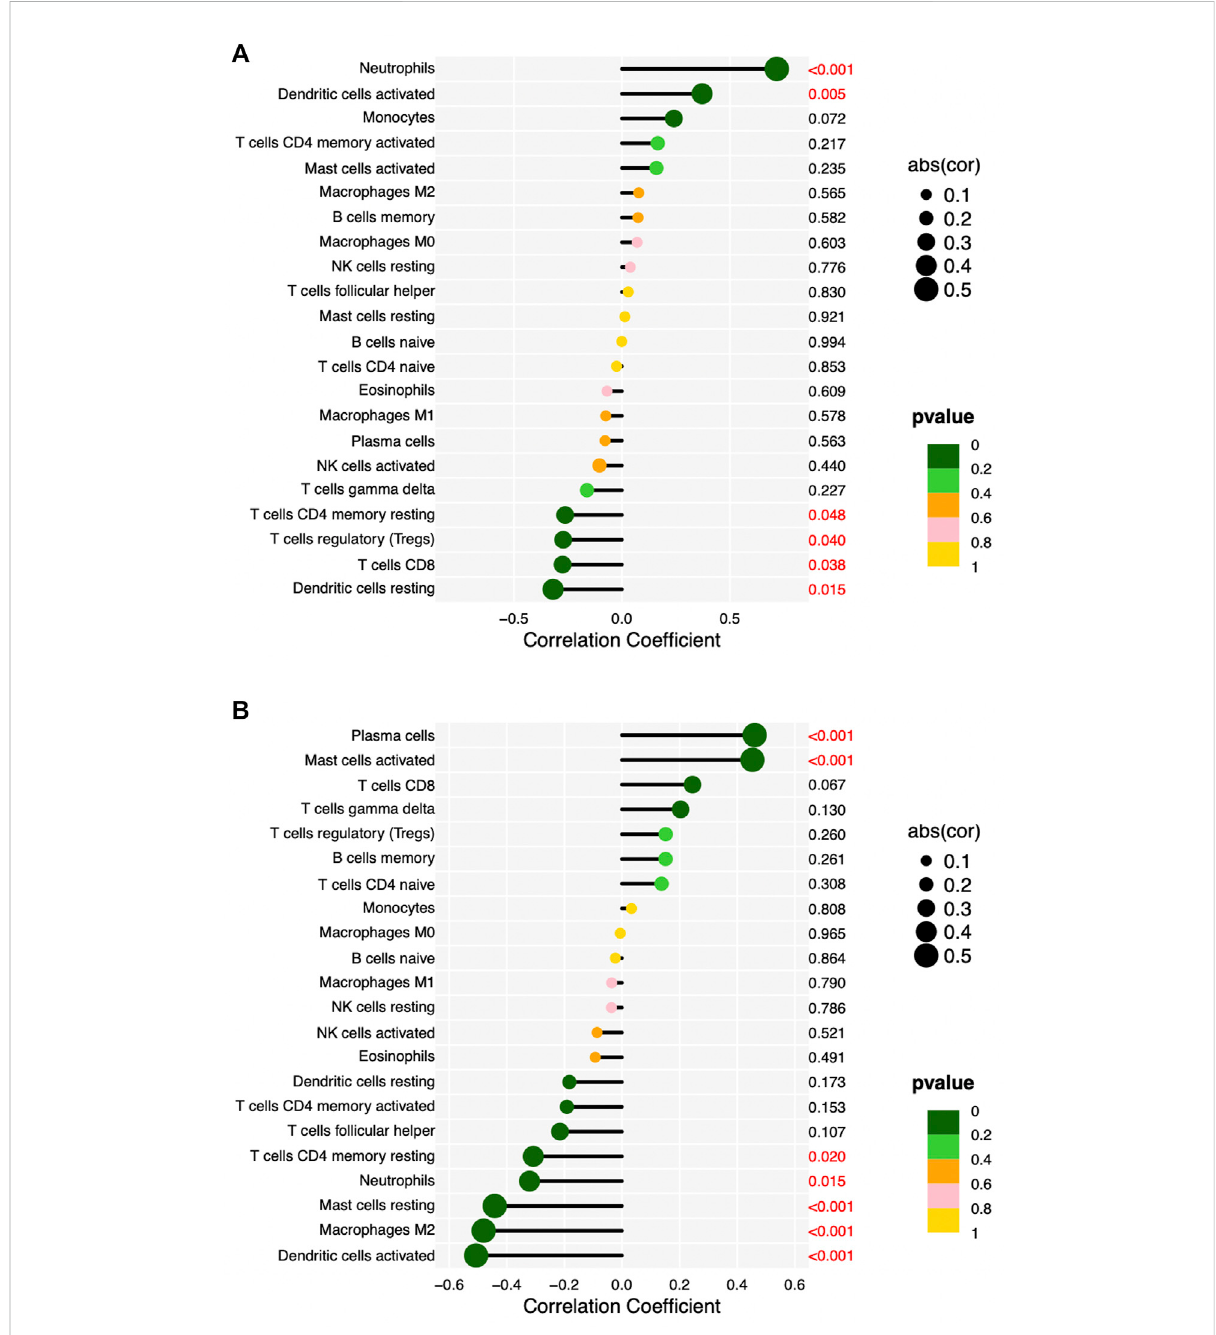
FIGURE 9 Lollipop diagram of correlation between FPR2 (A) or GNG7 (B) expression levels and 22 immune cell in fi ltrations. Circle size: absolute value of correlation coef fi cient; circle color: p -value of correlation test. p < 0.05 (red) indicates a signi fi cant correlation between FPR2 (A) or GNG7 (B) expression and immune cell